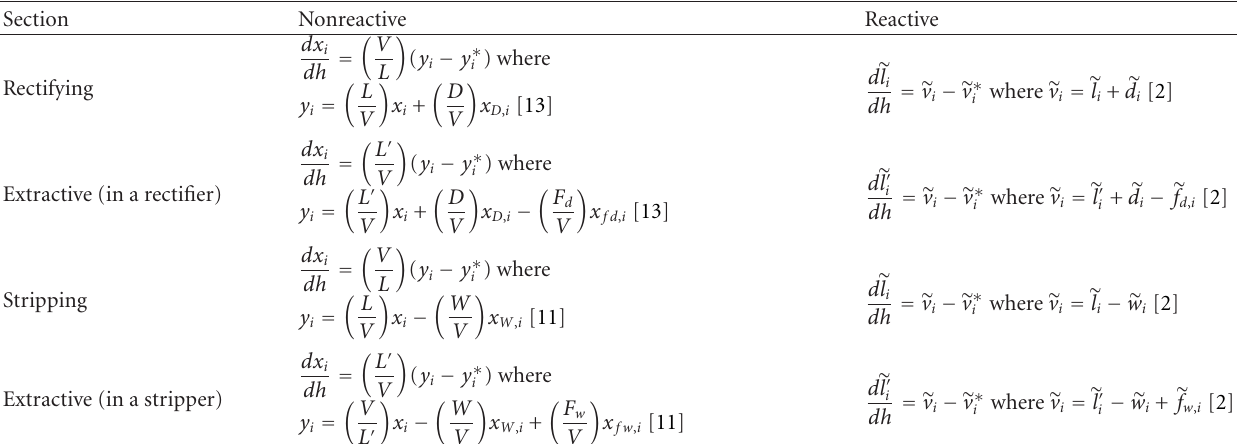
Table 1: Model equations of column sections for single-reaction systems.